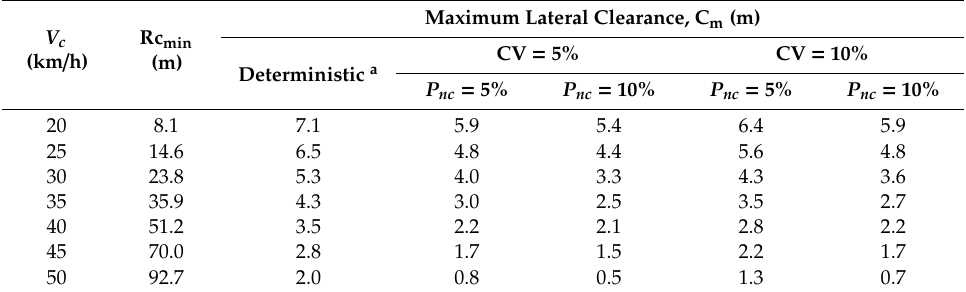
Table 7. Reliability-based maximum lateral clearance needs for the entry vehicle for single-lane symmetrical roundabouts, CV = 10% (approach vehicle 15 m from the yield line) a